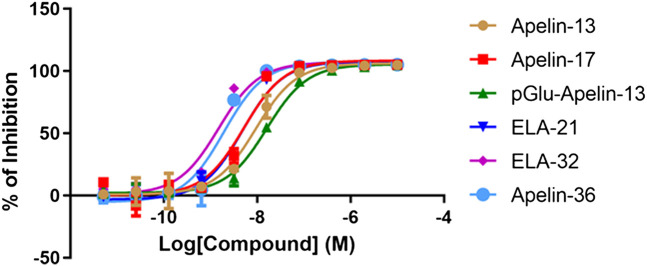
Radio-ligand competition results of the six peptides with [125I]-apelin-13. All data points were in triplicates and the standard errors were displayed in error bars. The inhibition rates have been normalized to Apelin-13.